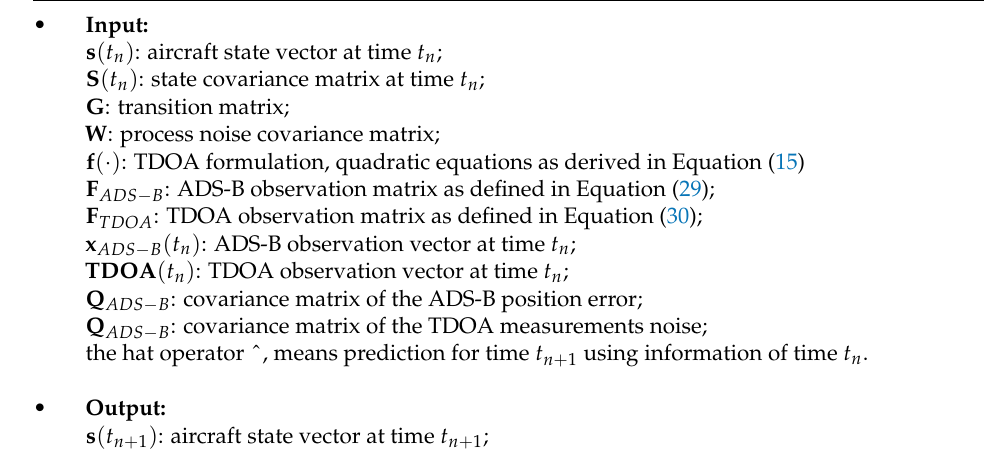
Table 1. Proposed